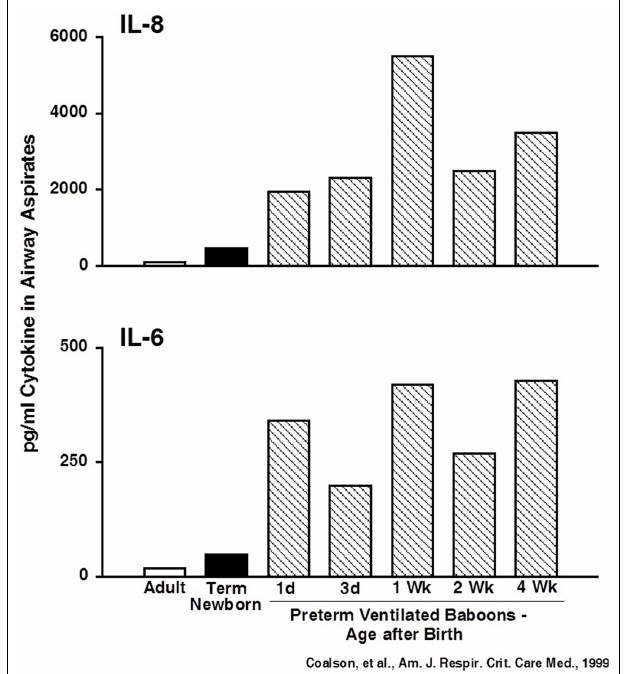
FIGURE 3 | Cytokines are persistently elevated in airway samples from ventilated preterm baboons . IL-6 and IL-8 were increased from day 1 to week 4 in preterm baboons progressing to BPD. Data redrawn from Coalson et al.